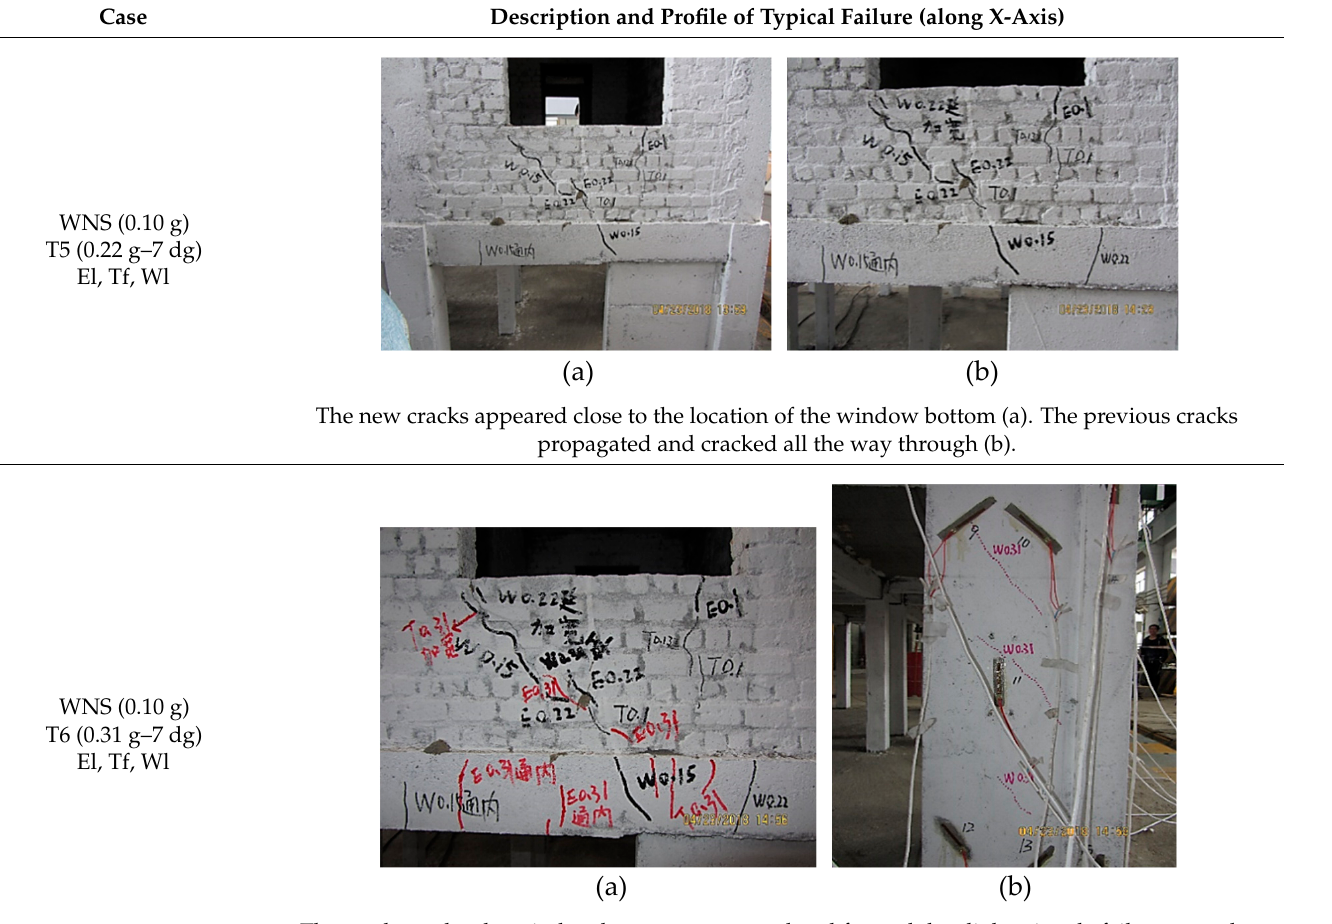
The cracks under the window bottom propagated and formed the slight triangle failure area; the cross cracks appeared at the upper part of the side beam (a). The oblique cracks appeared at the masonry wall close to the pedestal of the bottom frame (b).